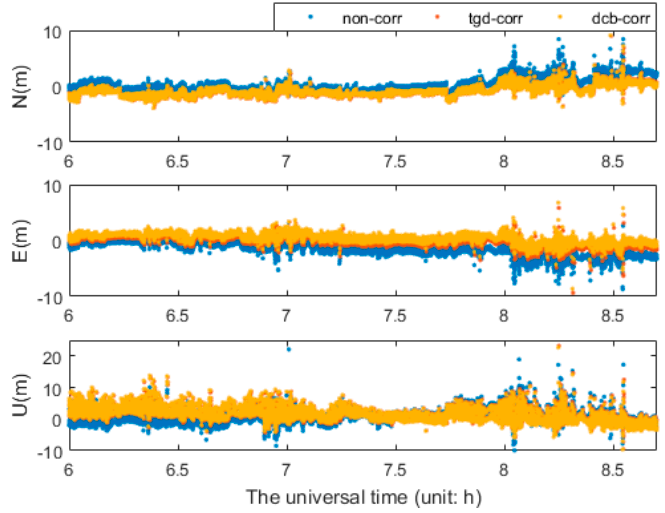
Table 6. RMS of multi-constellation SPP (unit: m).